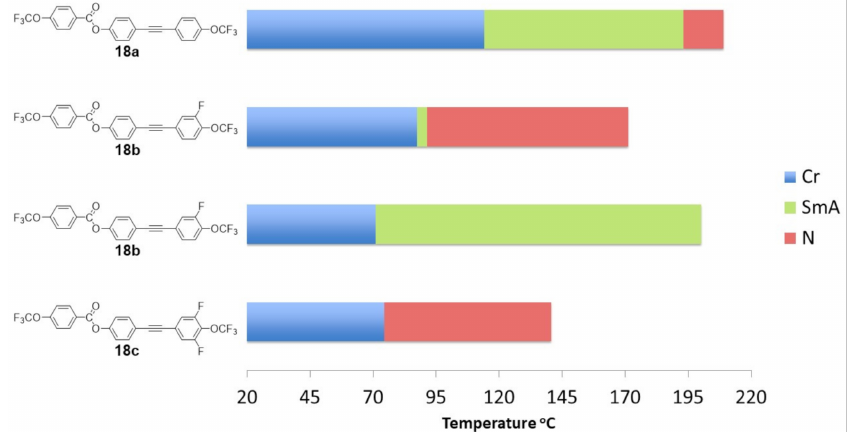
Figure 11. The influence of the number and position of fluorine atoms in the lateral position on the mesomorphic properties of tolane derivatives.